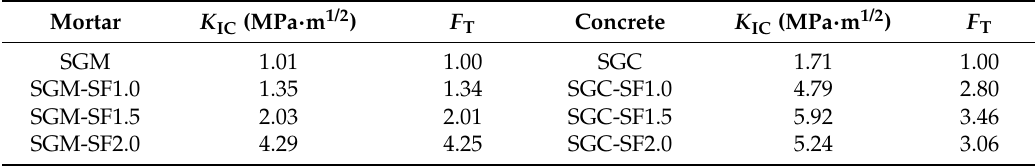
Table 7. Fracture toughness and reinforcing efficiency of steel fiber-reinforced SGM and SGC. Mortar